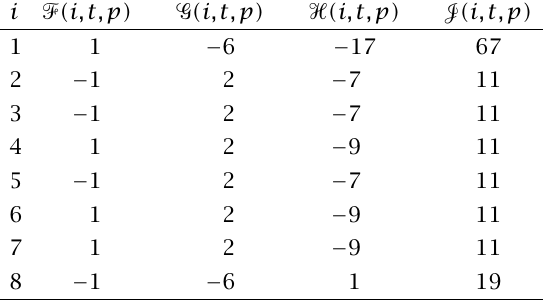
(cid:10) φ( − 1 ),φ(t),φ( 1 − t)